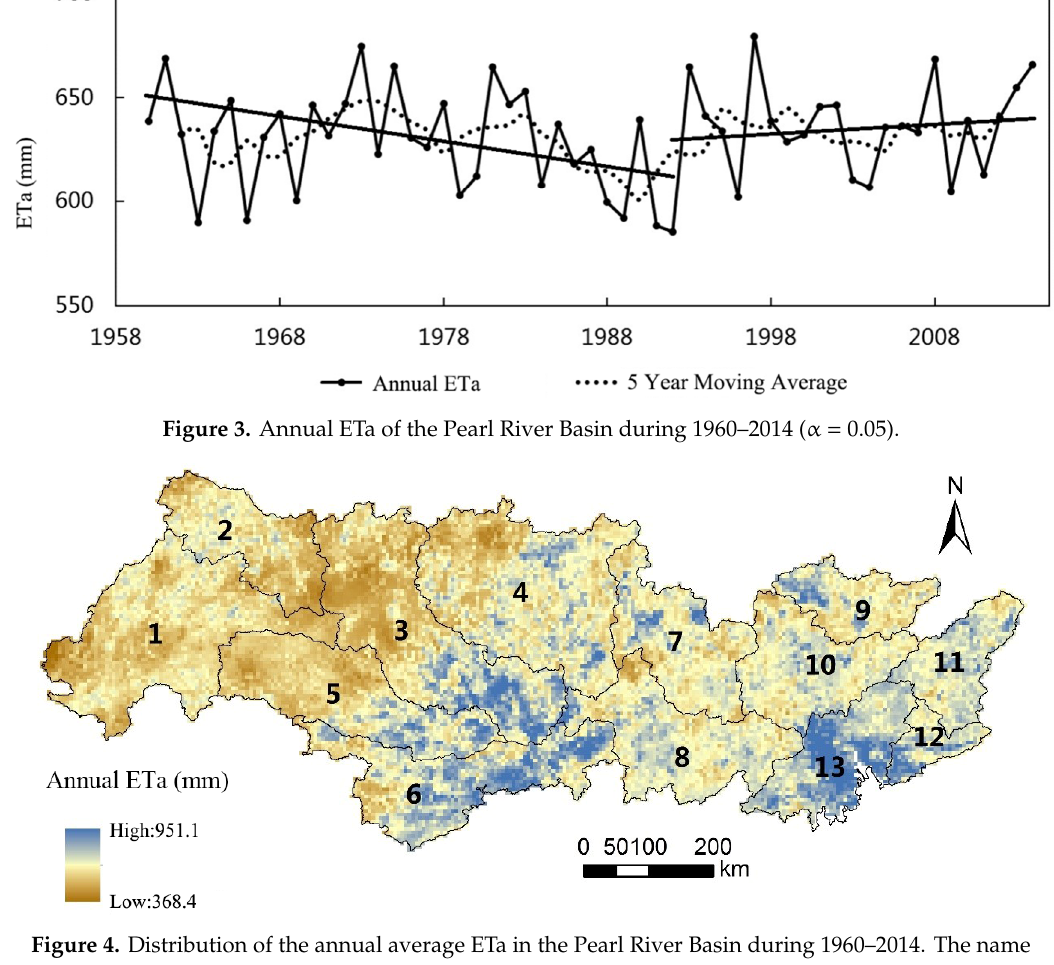
Figure 4. Distribution of the annual average ETa in the Pearl River Basin during 1960–2014. The name of the sub-regions refer to those in Figure 1.